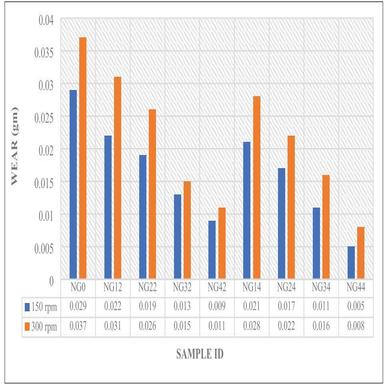
Wear rate for bio composite epoxy specimen.